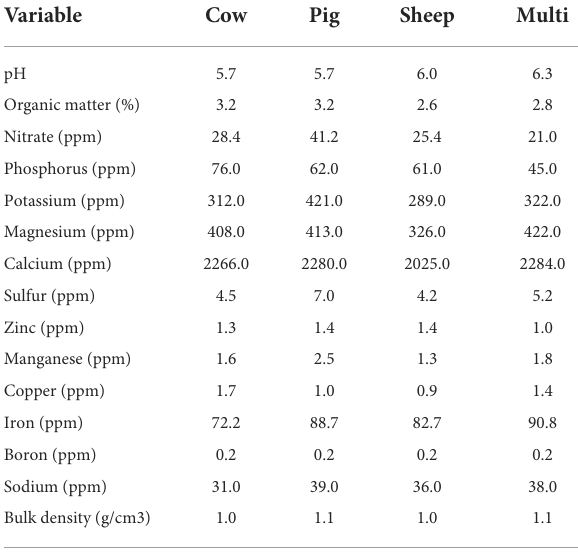
TABLE 2 Proportion of shared taxa for each microbial kingdom, calculated across grazing treatments within months and across months within grazing